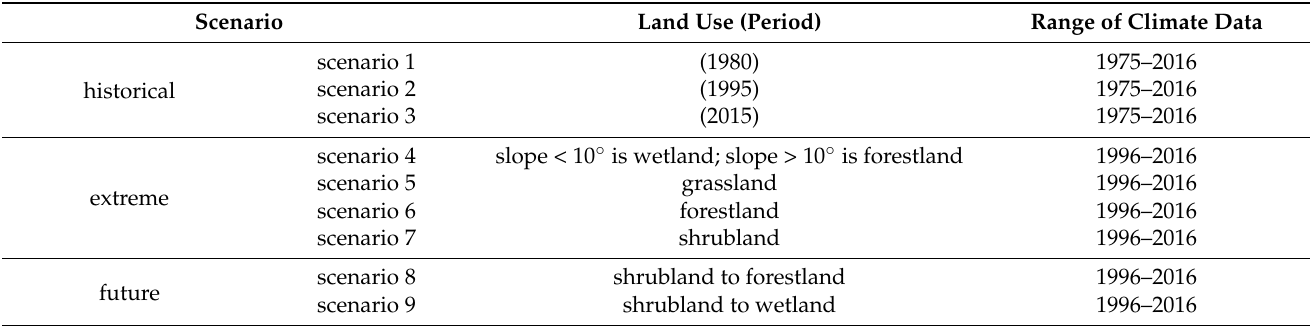
Table 1. Land-use scenarios in the Tahe River